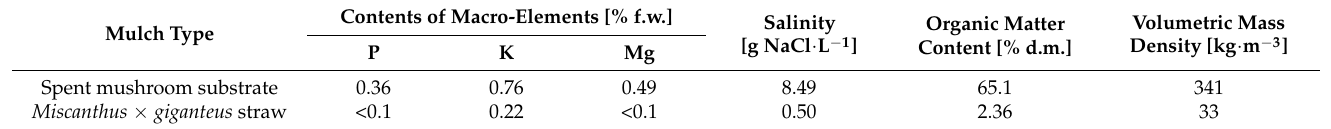
Table 1. Physico-chemical properties of mulches used in the